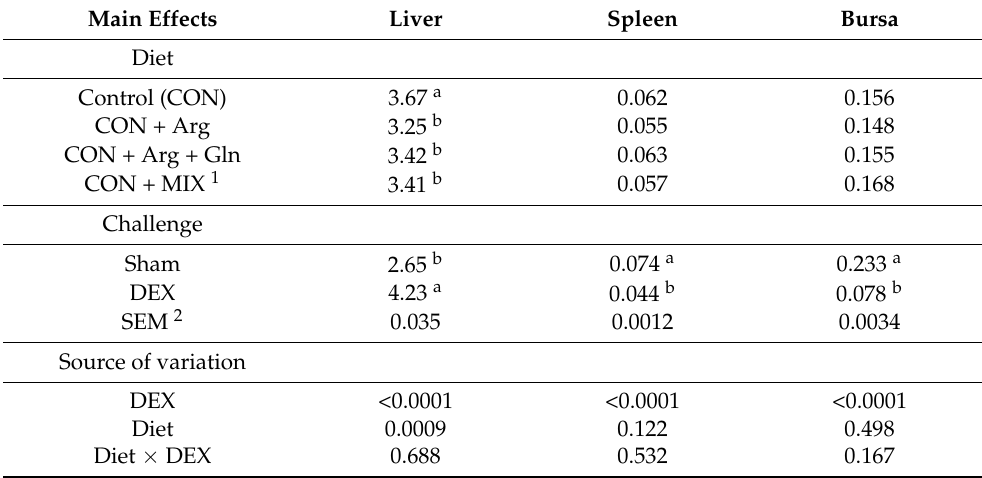
Table 6. Relative weights (g/100 g BW) of liver, spleen, and bursa of broiler chickens fed four experimental diets subjected to dexamethasone (DEX) or sham injections (experiment